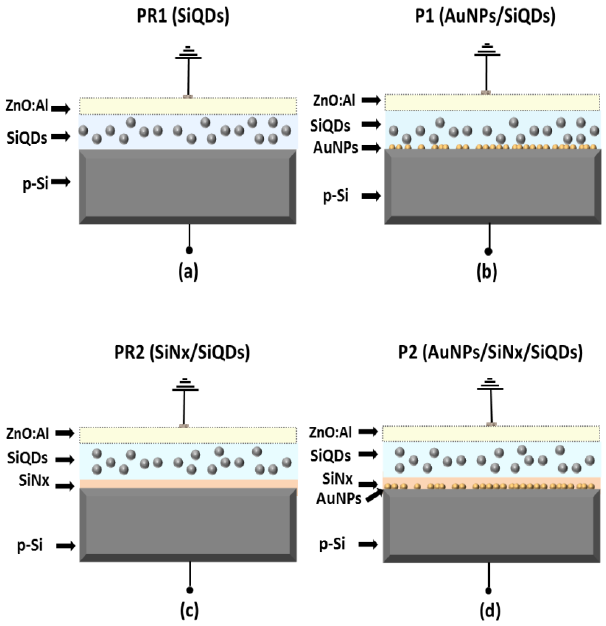
Figure 1. ( a – d ) Schematic representation of the fabricated structures PR1, P1, PR2, and P2.